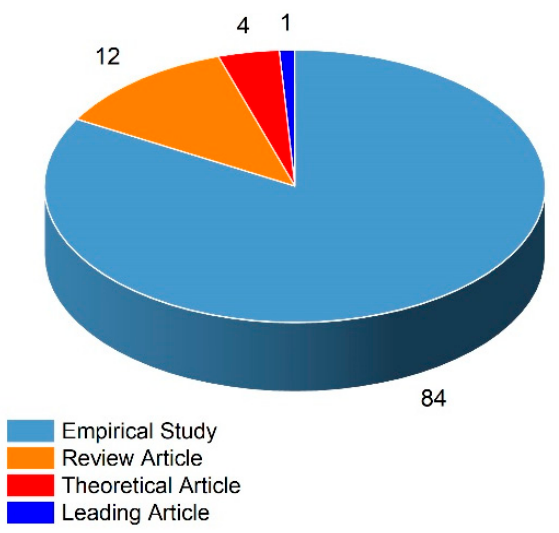
Figure 2. The number of published articles per year with keywords in the topic.